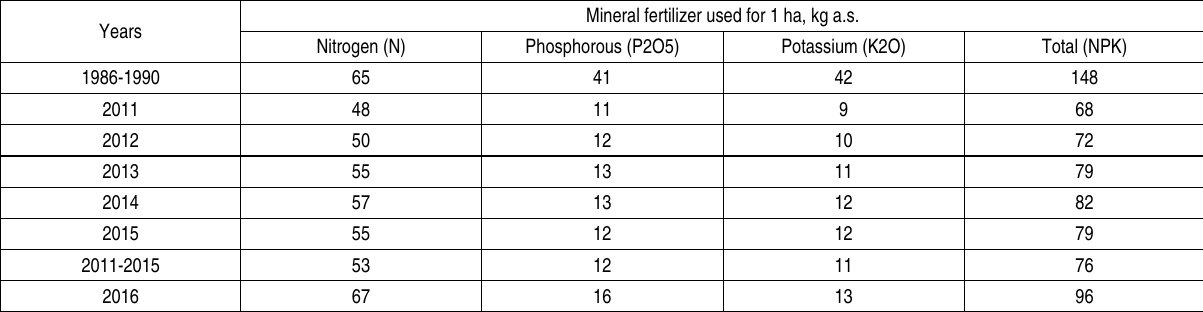
Table 1. Applying mineral fertilizers in agriculture of Ukraine